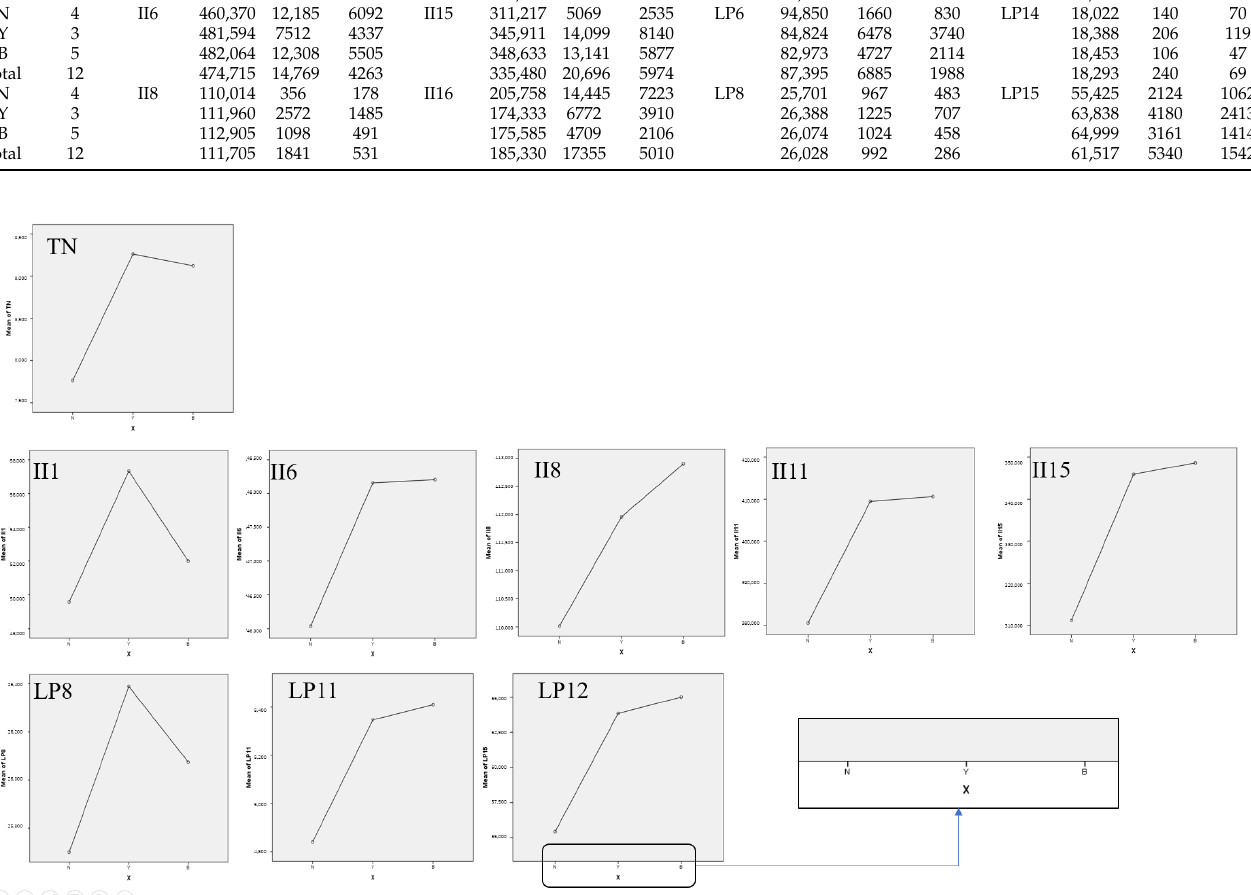
Figure 8. Mean Plots (Positive